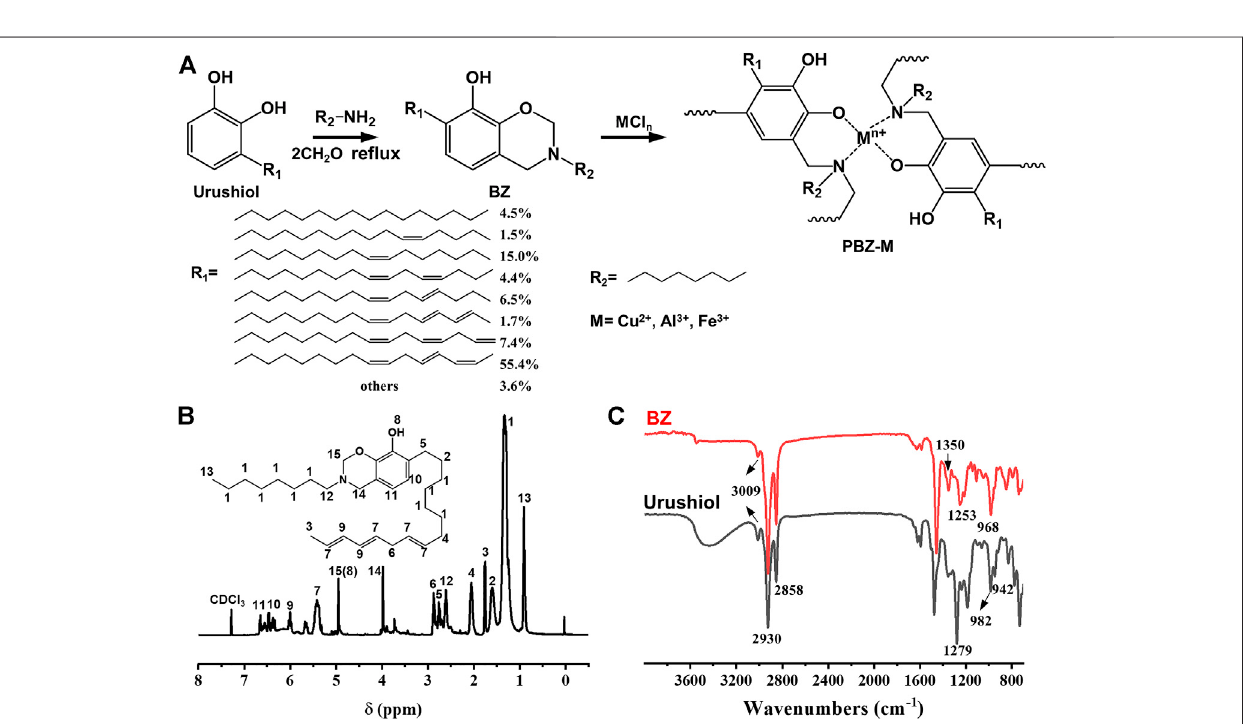
FIGURE 1 | (A) Synthesis of BZ and PBZ-M. (B) 1 H-NMR spectrum of BZ. (C) FTIR spectrum of urushiol and BZ.